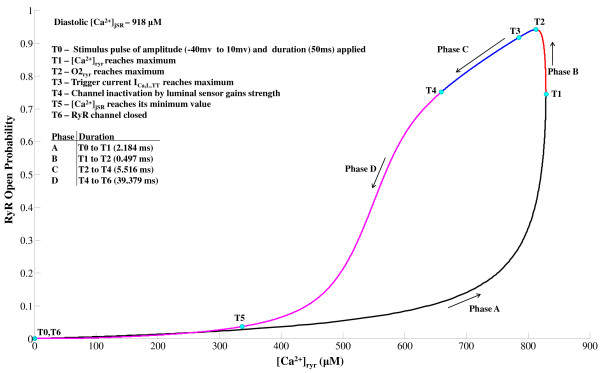
Ryanodine receptor open probability. Figure 15: RyR open probability modulation by concentration at the mouth. The pre-release diastolic [Ca2+]jSR is 918 μM. The stimulation protocol used is a pulse of amplitude (-40 mv to 10 mv) and duration (50 ms). Phase A - As a result of excitation by the trigger current, [Ca2+]ryr initially increases rapidly with a small accompanying rise in RyR open probability followed by steeper increase to peak [Ca2+]ryr with a large increase in RyR open probability.; Phase B - RyR open probability increases to its maximum value at a declining rate reflecting a falling [Ca2+]ryr level and onset of Ca2+ induced self-inhibition; Phase C - Decreasing Ca2+dyad and continued Ca2+ induced self-inhibition, begins the channel recovery process; Phase D - Decreasing [Ca2+]jSR forces a strong RyR inactivation via the luminal sensor hence robustly closing the channel.